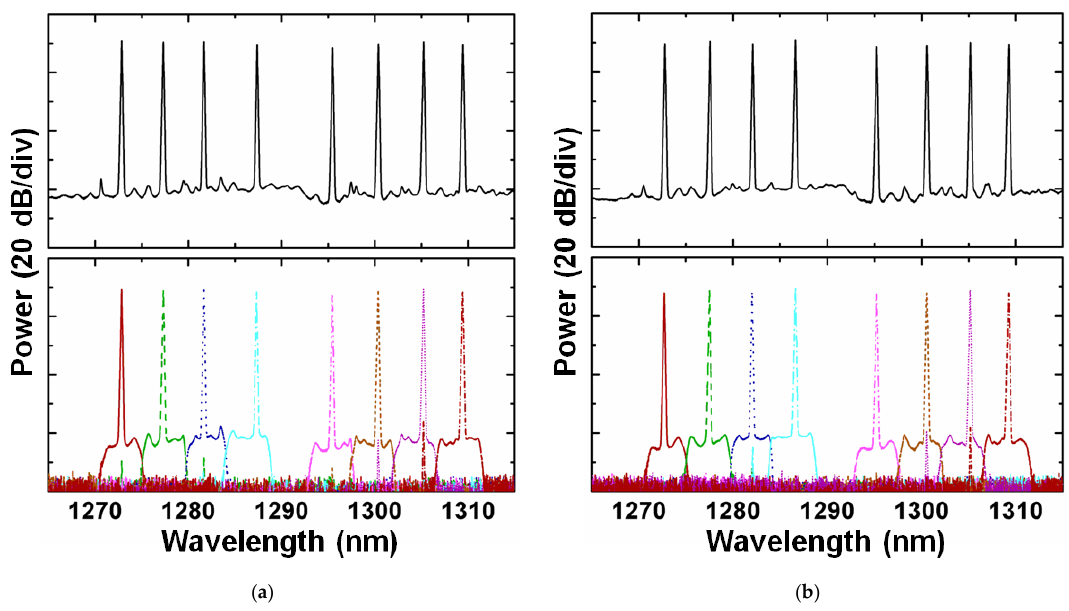
Figure 8. Optical spectra of two CFP8-LR8 modules: ( a ) first sample module; ( b ) second sample module. Top: spectrum at the output of the transmitter; Bottom: spectra of the individual lanes after going through a de-multiplexer.